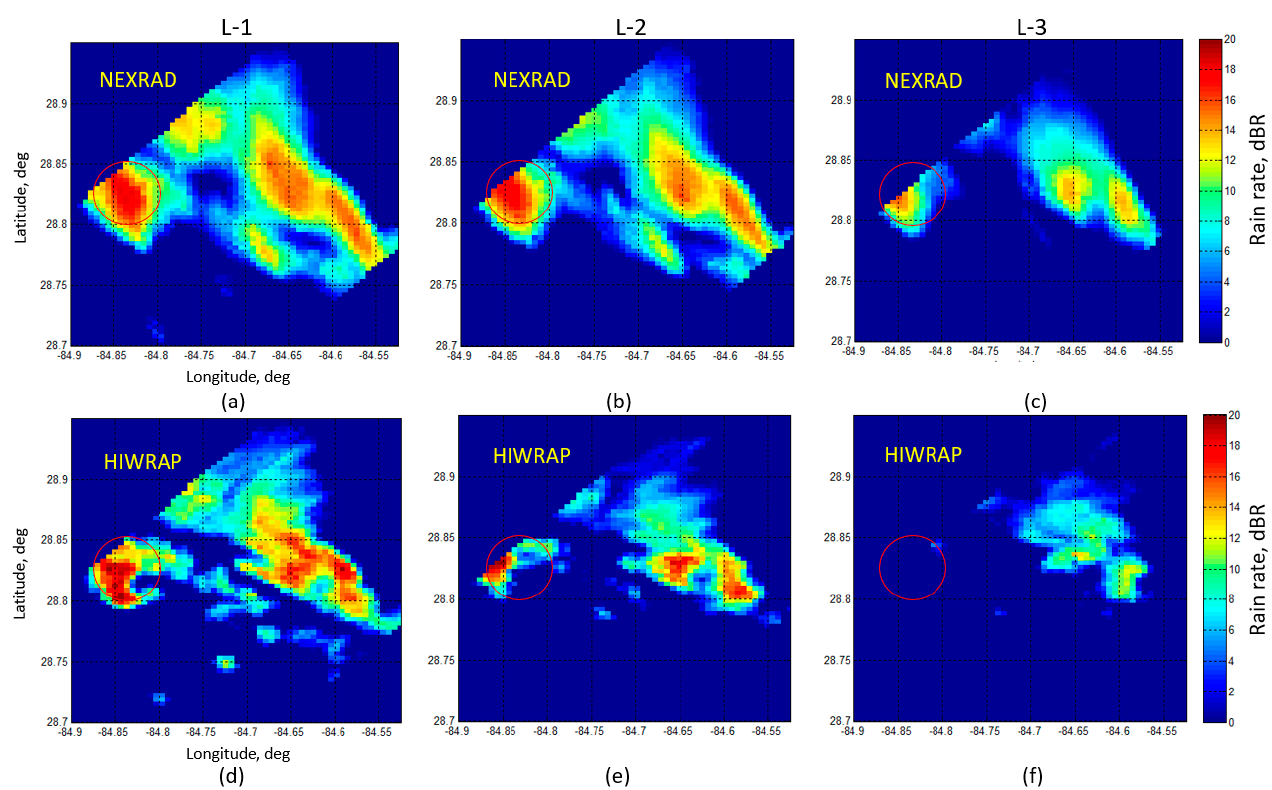
Figure 10. NEXRAD and HIWRAP collocated rain rate CAPPI images. Columns L-1, L-2 and L-3 correspond to the altitudes (3.5, 4.5, and 6 km) of the first three layers of the NEXRAD volume scan. Each column contains NEXRAD (top panels ( a – c )) and HIWRAP (lower panels ( d – f )). The color bar represents rain rate in dBR. The red circles indicate the region of NEXRAD rain rate vertical profile aliasing.